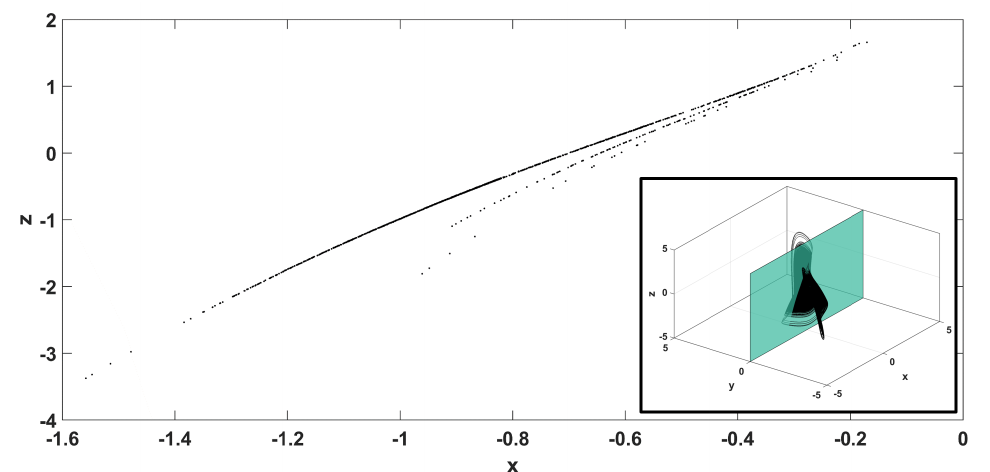
Figure 7. Poincaré map of x versus z for a = 0.65, b = 0.1.